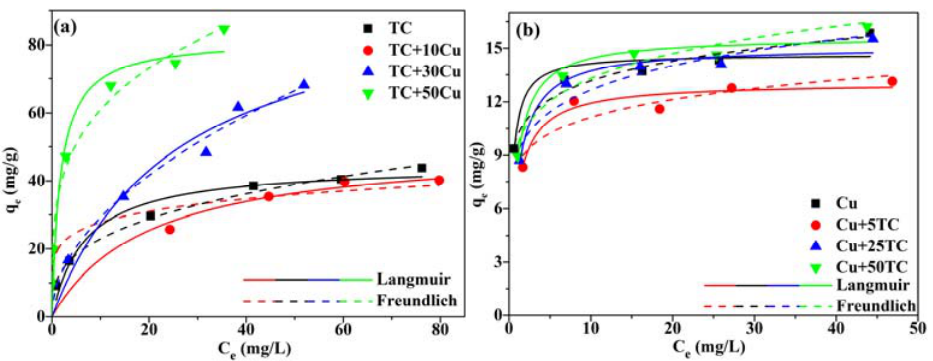
Figure 5. The isotherms of ( a ) TC and ( b ) Cu( Ⅱ ) fitted with Langmuir and Freundlich models under the single and binary system.